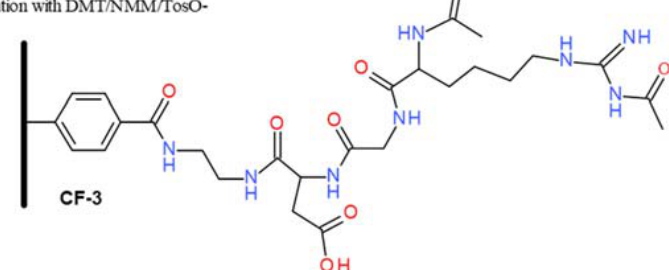
Figure 6. Scheme of the modification of the nonwoven CF-1c with ethylenediamine and Ac-RGD- OH peptide.